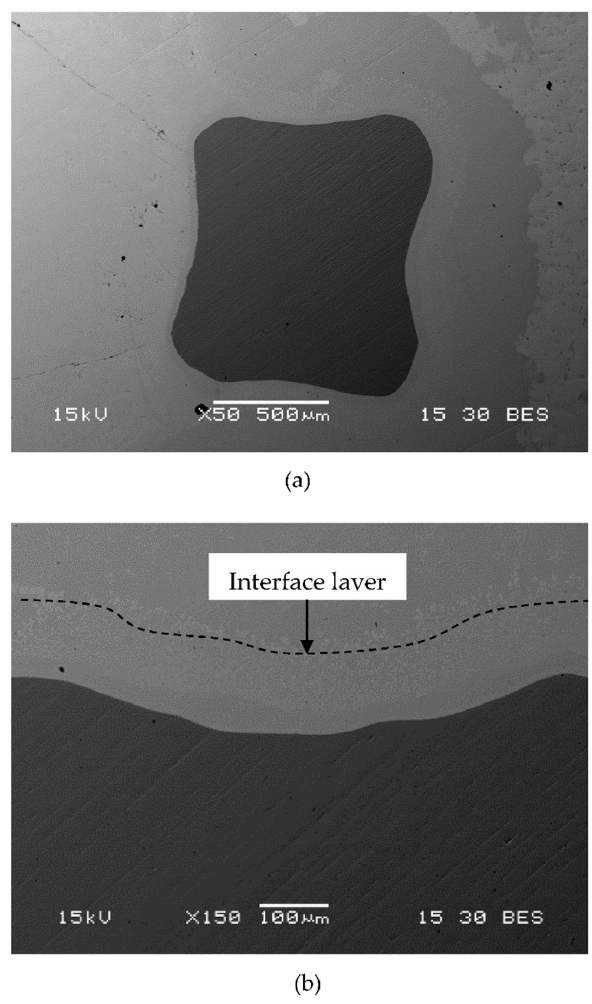
Figure 2. General appearance of the boundary between the Ti–6Al–4V lattice and the infiltrated Zn–2%Fe alloy: ( a ) close-up view and ( b ) magnified view of the interface layer between the two alloys. In order to evaluate the characteristics of the interface layer between the Ti–base lat- tice rods and the infiltrated Zn–2%Fe alloy, the chemical composition of this layer was analyzed by energy-dispersive spectroscopy (EDS), as shown in Figure 3. This has indi- cated that a relatively large amount of Ti was present in this layer, along with a large amount of Zn. According to the spot chemical analysis shown in Figure 4 (points 2 and 3), the amount of Ti in this layer was within the range of 20.2–23.4%, along with 0.5–1.7% Fe. In parallel, the content of other alloying elements composing the Ti-base lattice (Al and V) within this layer were relatively minor compared to their original content in the Ti–6Al– 4V alloy.